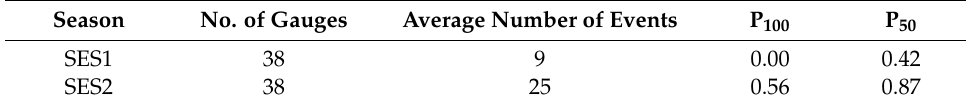
Table 2. Probabilities of daily rainfall coverage.